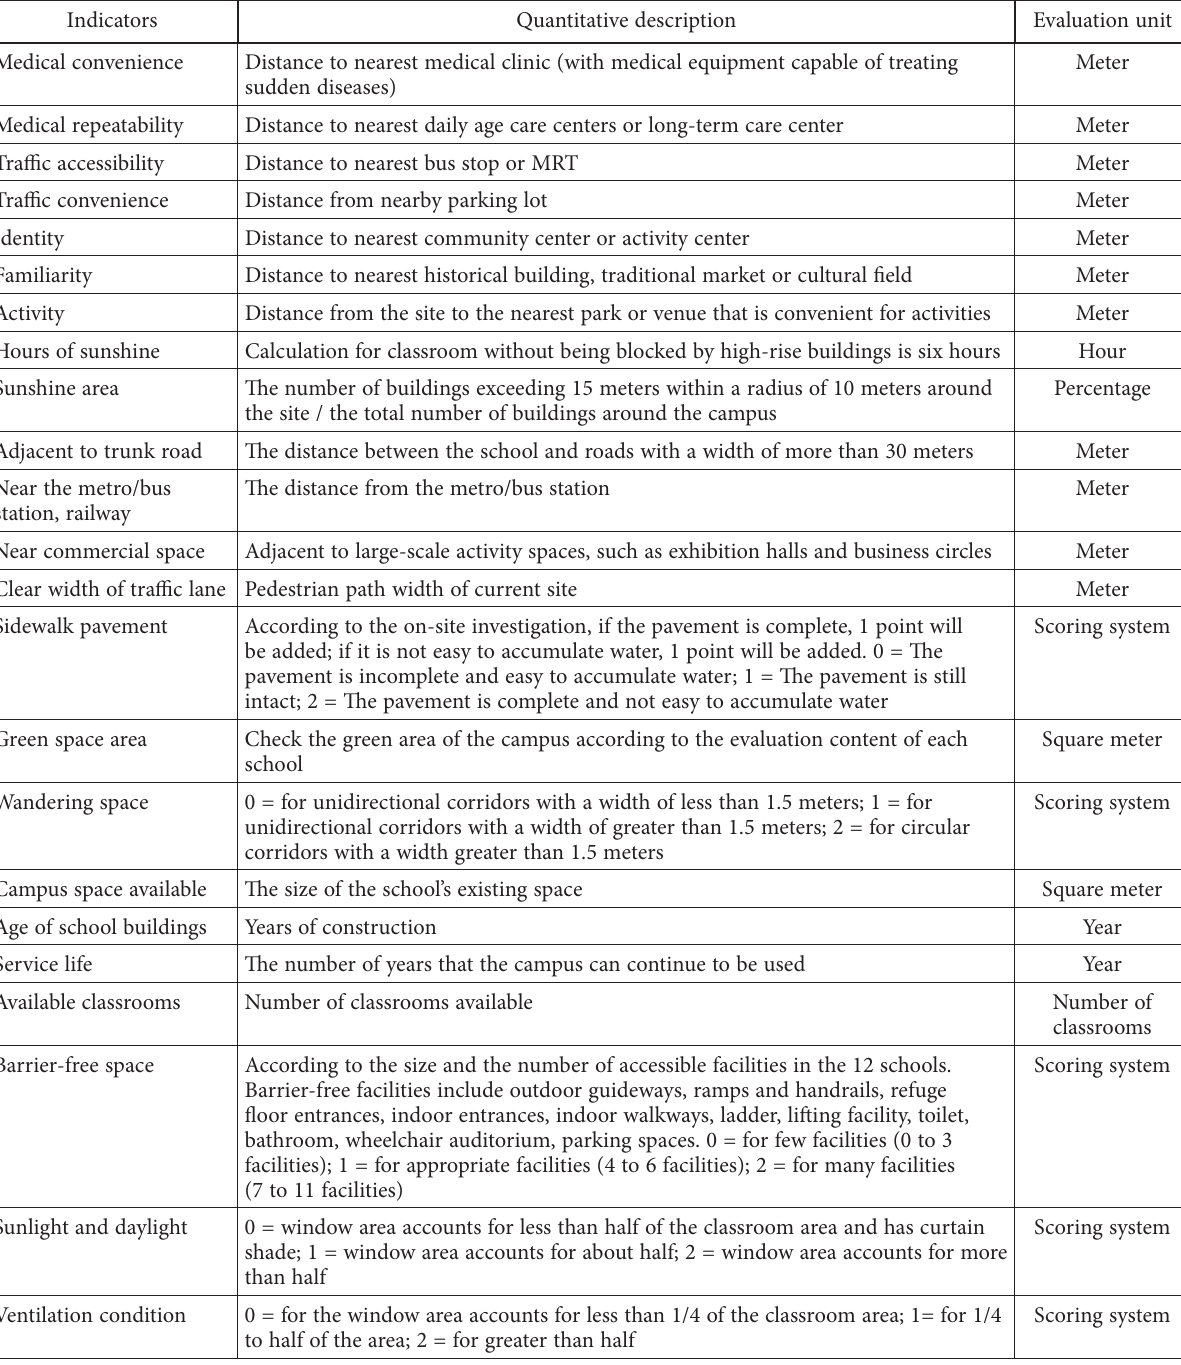
Table 6. Numerical description of evaluation